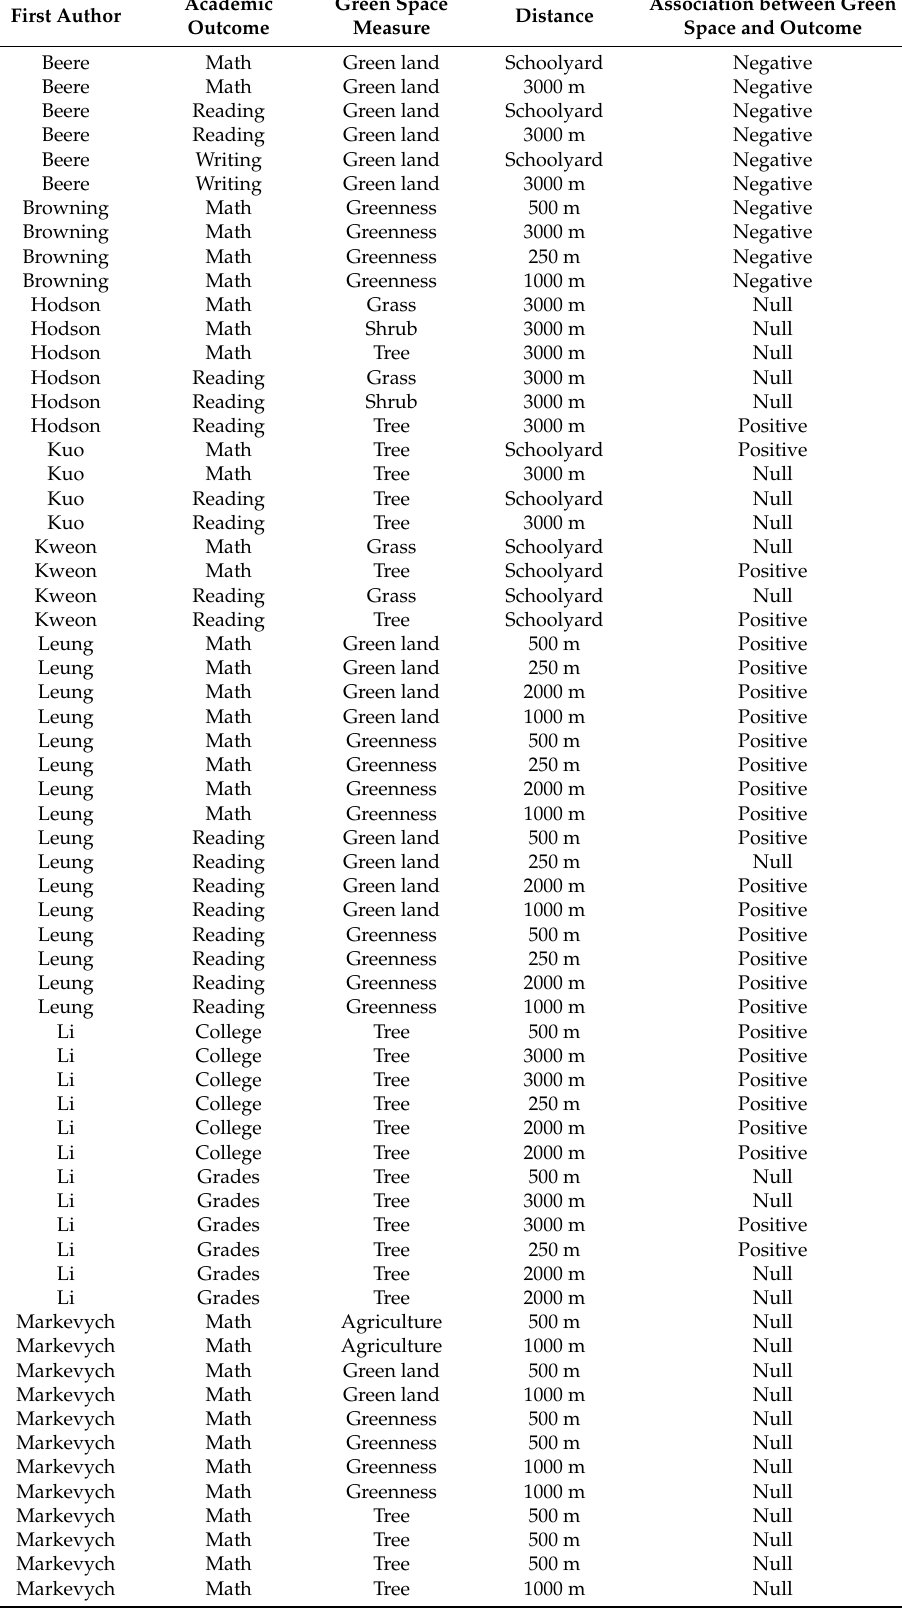
Table A2. Outcomes and green space measures identified in the selected